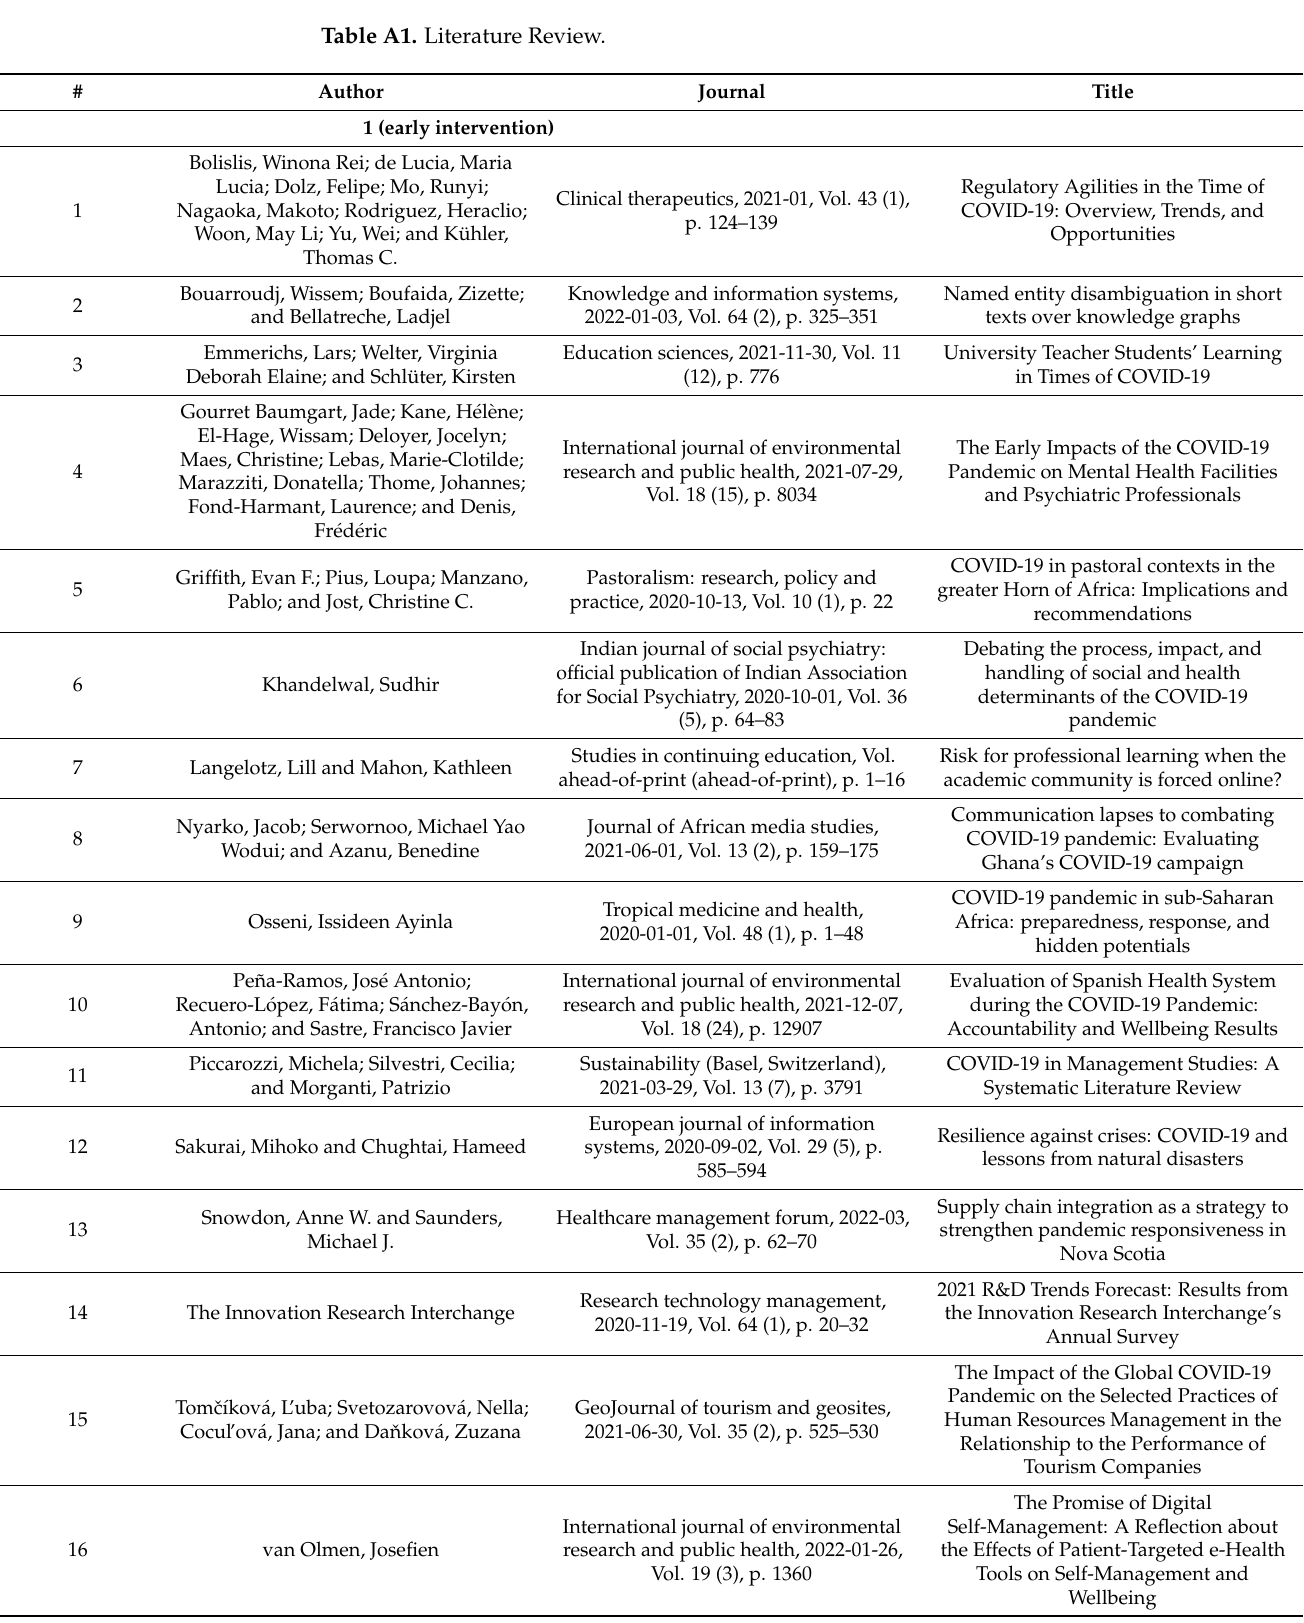
Table A1. Literature